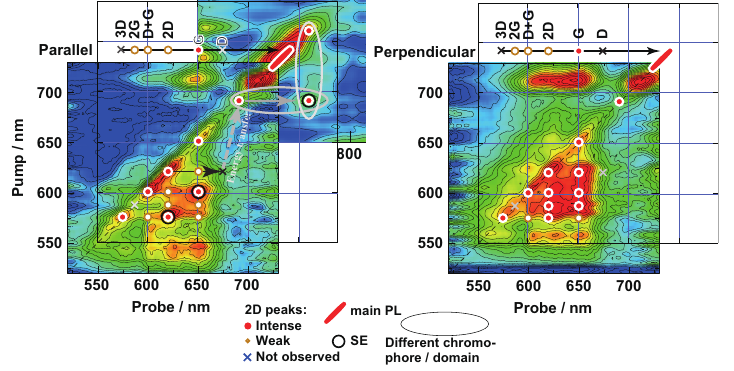
Figure 2. 2DES maps of GNR in VIS and NIR at t 2 = 1 ps for parallel and perpendicular polarization combinations. At 735 nm, which exactly matches the PL peak in Fig. 1, the lowest main exciton peak is seen. The main exciton transition coupled to vibrational modes of D, G, 2D, D + G, 2G and 3D form these mesh grid-like structures. The diagonal peaks at 690, 760 nm and their cross peak are assigned to a di ff erent exciton